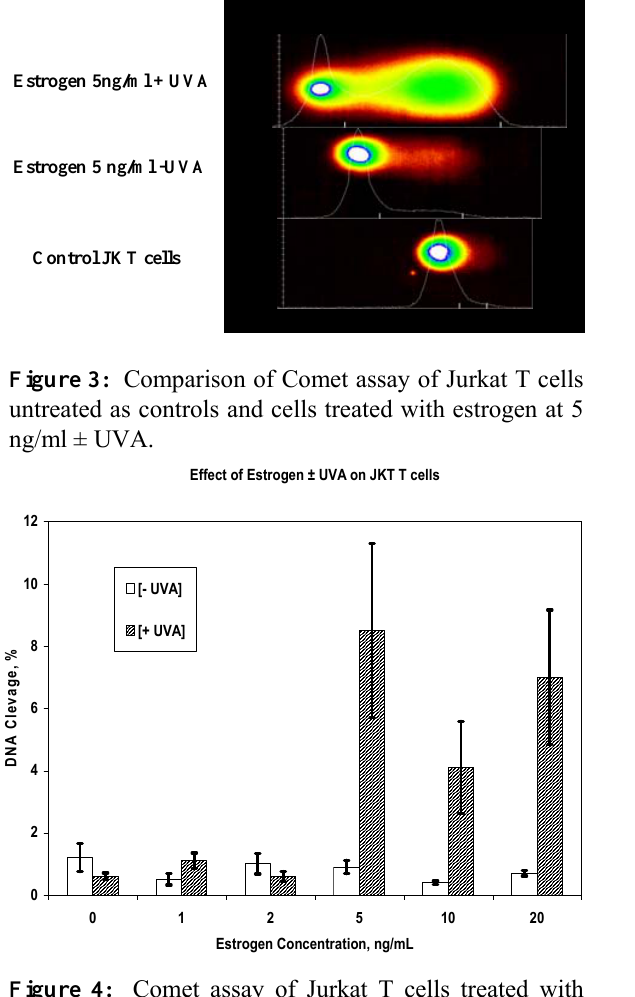
Figure 7: DNA laddering of cells treated with estrogen ± UVA. Western blot (Figure 8) shows that bcl-2 was significantly and equally down regulated by estrogen and that ± UVA radiation had no effect. p53 is absent from the cells that were not treated with estrogen but was present when estrogen was added. UVA treatment decreased p53 expression.